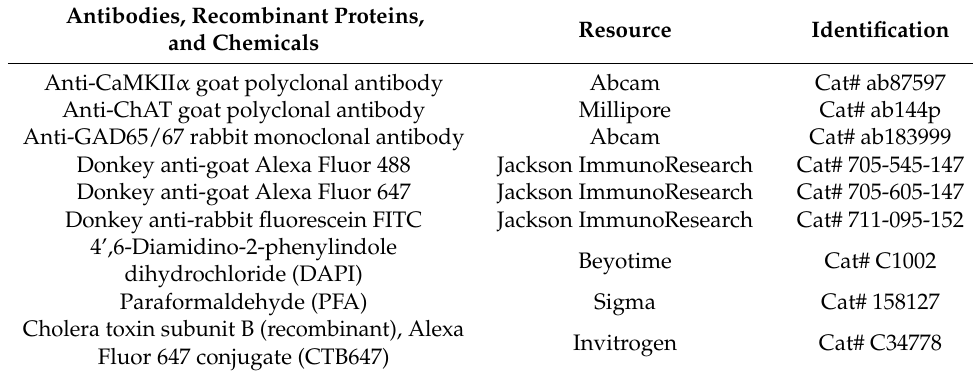
Table 2. Reagents used for histology and imaging. Antibodies, Recombinant Proteins, Resource Identification and Chemicals Anti-CaMKII α goat polyclonal antibody Abcam Cat# ab87597 Anti-ChAT goat polyclonal antibody Millipore Anti-GAD65/67 rabbit monoclonal antibody Donkey anti-goat Alexa Fluor 488 Donkey anti-rabbit fluorescein